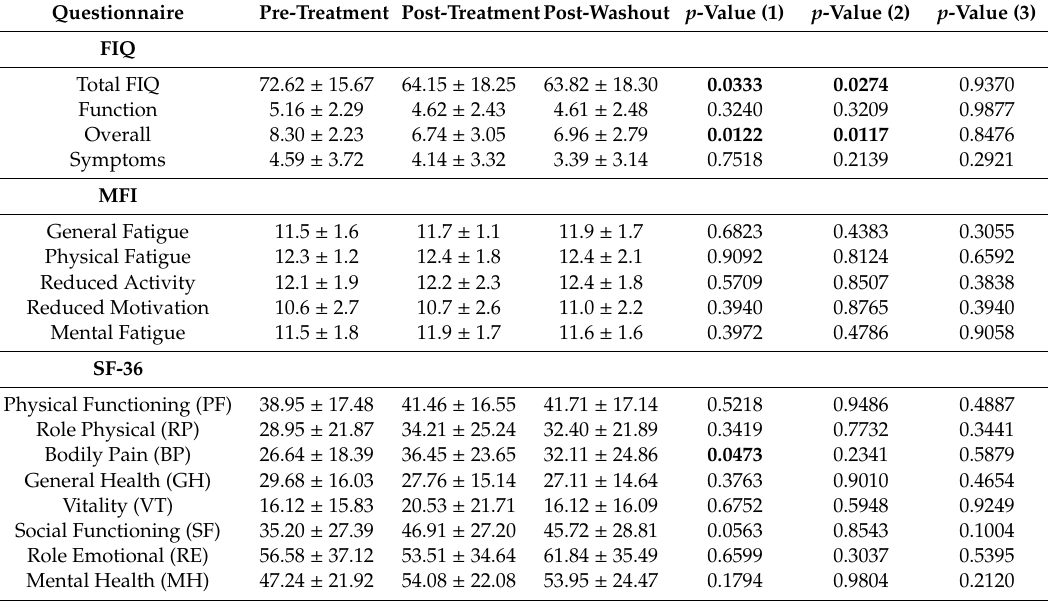
Table 3. Patient response to therapy as evidenced by score di ff erences in the standard, validated, FIQ, MFI and SF-36 instruments [36–39].